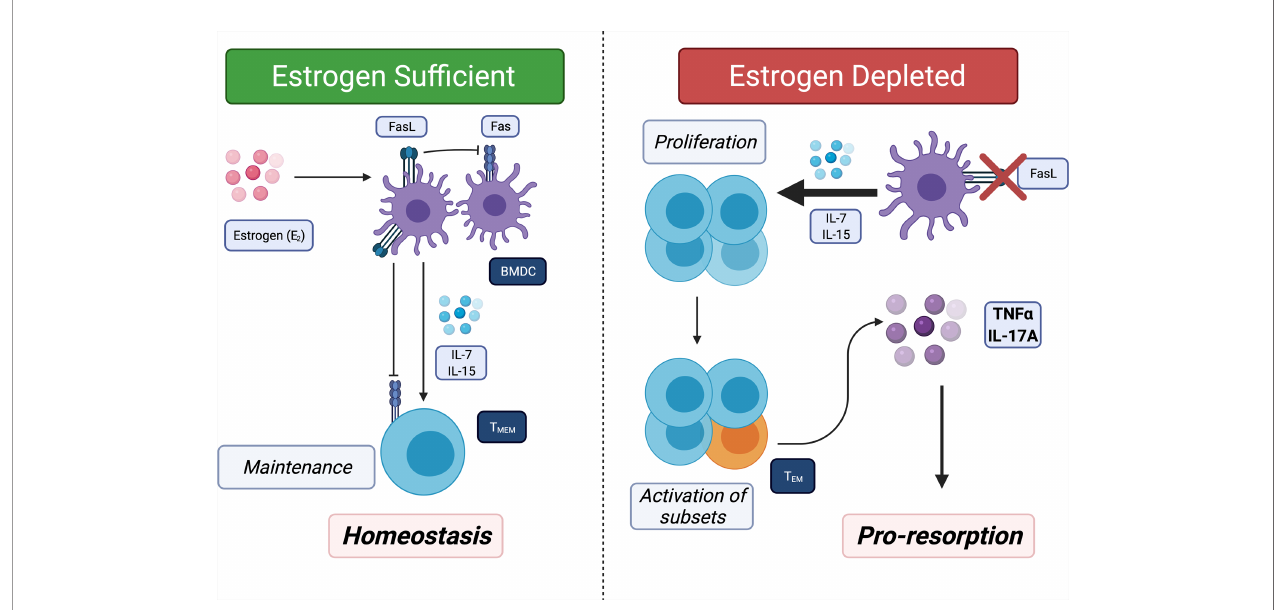
FIGURE 2 | Estrogen (E 2 ) regulates bone marrow resident memory T-cells (T BRM ) homeostasis and E 2 loss promotes conversion of T BRM to T EM . T M migrate to and take up long-term residence in the bone marrow. Left panel : Bone marrow resident dendritic cells (BMDC) secrete IL-7, IL-15 or both to promote survival of T M . In E 2 replete females, BMDC have a short lifespan because E 2 induces FasL in the BMDC. In addition, IL-15 induces Fas in proliferating T M in response to IL-7 and IL-15 thus maintain a homeostatic pool of T BRM . Right : In absence of E 2 , Fas ligand (FasL) is no longer induced leading to increased lifespans of BMDC and high concentrations of IL-7 and IL-15. In the presence of high IL-7 and IL-15 and absence of FasL, all T M proliferate and a subset (~5 to 10%) produce TNF a and IL-17A, which then promotes bone resorption and also limits bone